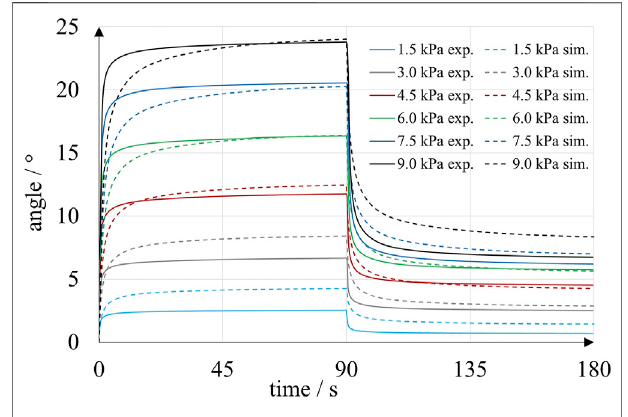
FIGURE 13 | Time-dependent angular position of inkjet-printed rotary bellows actuators in experiments (solid lines) and simulation (dashed lines). Each solid curveis an average of fi ve experiments with four bellows chambers at a particular pressure level.